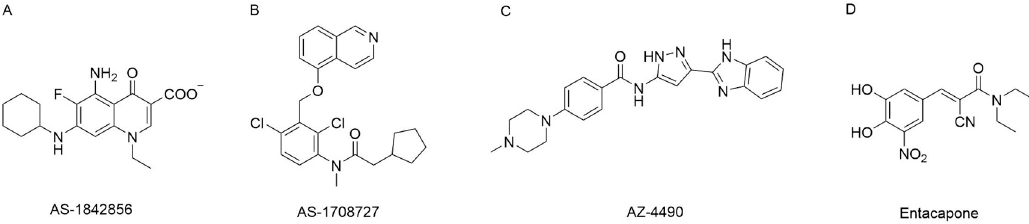
Figure 5. Inhibitors of the FOXO1 protein and FOXO1 pathway. ( A , B ) Inhibitors of the FOXO1 protein. ( C ) Inhibitors of FoxO1 -dependent glucose production without enhancing lipogenesis. ( D ) Entacapone suppressing FOXO1 protein expression through inhibiting fat mass and obesity-associated protein (FTO) enzymatic activity.